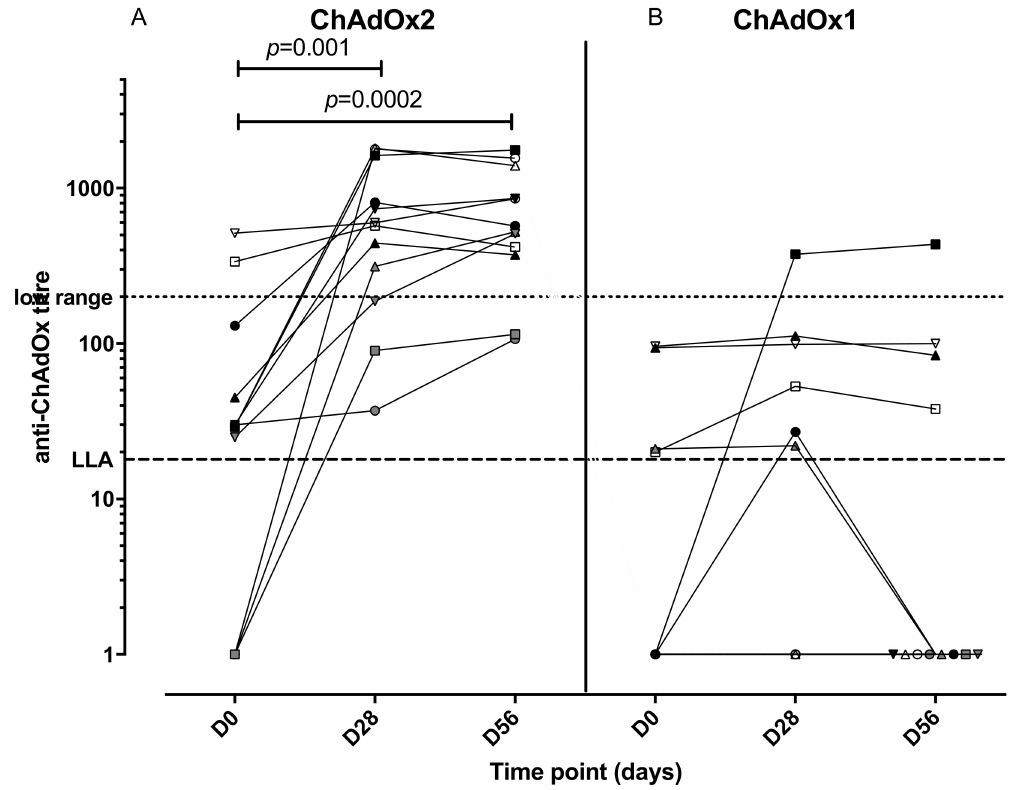
Figure 4. Anti-ChAdOx2 ( A ) and ChAdOx1 ( B ) vector neutralizing antibody titres at di ff erent timepoints (pre-enrolment, day 28 and day 56 post vaccination). LLA: lower limit of assay for accurate quantitation. Titres of neutralizing antibodies to ChAdOx2 increased significantly at day 28 and 56 compared with day 0 (Friedman test with Dunn’s multiple comparison test), but not to